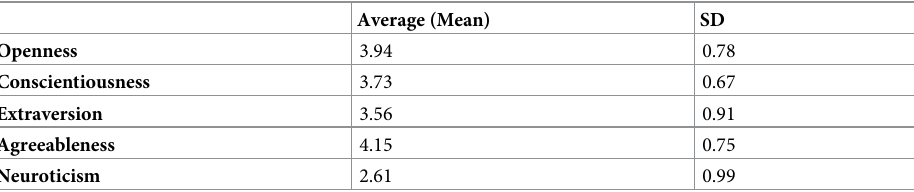
Table 3. Means and standard deviations for the B-5 personality dimensions survey.